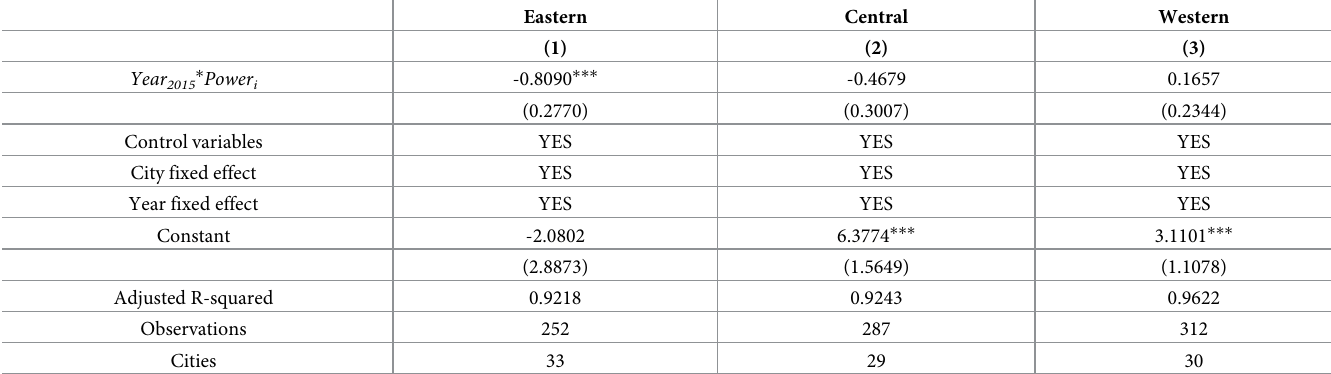
Table 11. Regional heterogeneity.